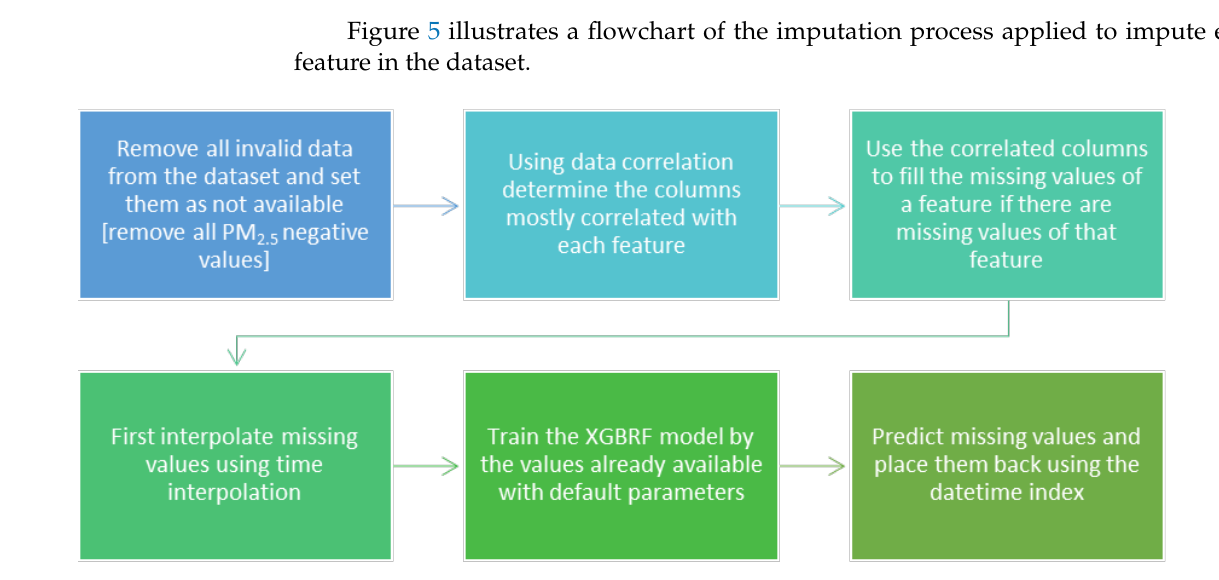
Figure 5. Imputation flowchart for every feature in Piccadilly station, Manchester, UK.